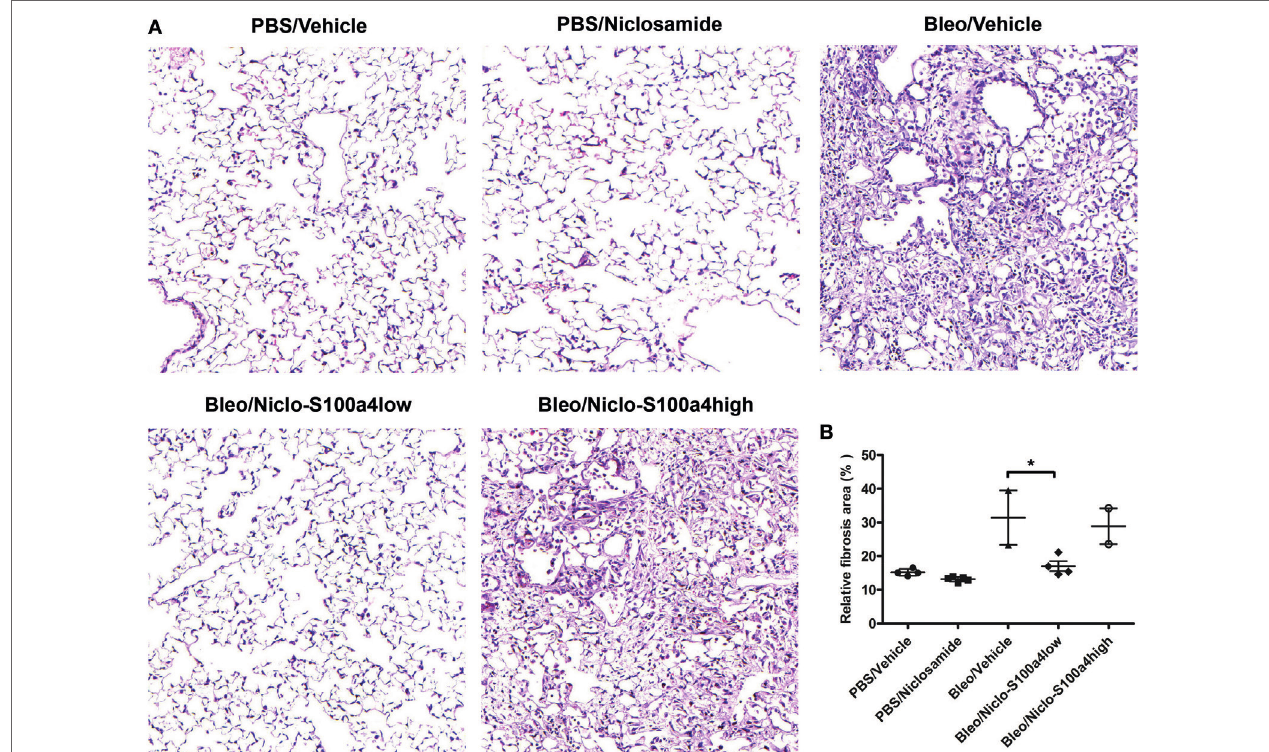
FigUre 8 | Treatment with niclosamide reduces the histological evidence of fibrosis. Lung tissue of the surviving mice depicted in Figure 7 was subjected to histological analysis. (a) Representative images of H/E-stained lung sections. (B) Quantitative analysis of all HE-stained sections. Each symbol represents a mouse. For each mouse, 3–5 sections were scanned using ImageJ. Results are shown as mean ± SD. Unpaired t -test was performed for statistical analysis (* denotes p <